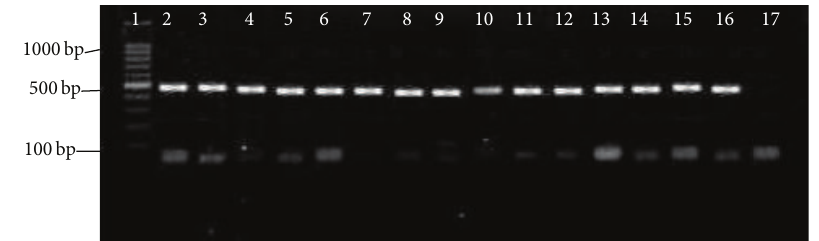
Figure 2: PCR results of pilA . 1 = marker = 100bp; 2–16 = pilA = 495 bp; 17 = negative control.